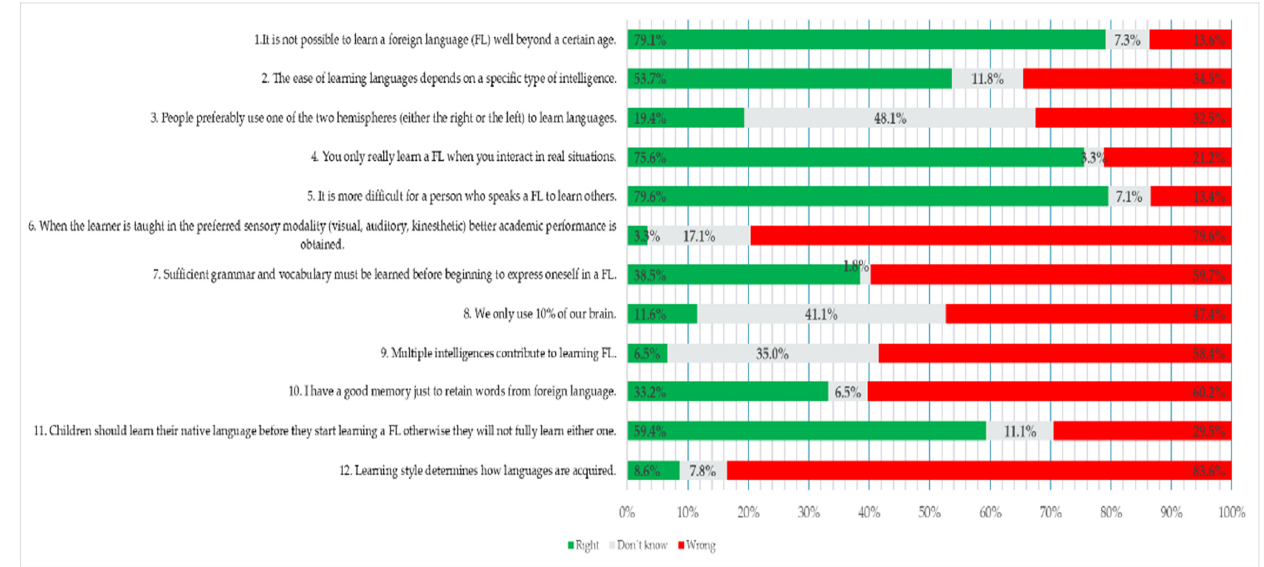
Figure 4. Responses by the study participants showing whether they responded correctly, incorrectly, or whether they did not know the answer.